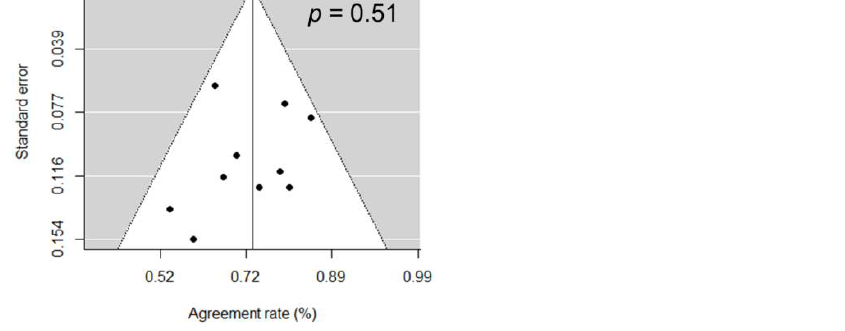
Figure 5. Funnel plot of the 10 included studies suggesting no publication bias being present. Table 3. Subgroup analysis of concordant proportion between PSA and PSMA PET response assessments stratified to therapeutic agent and PSMA PET